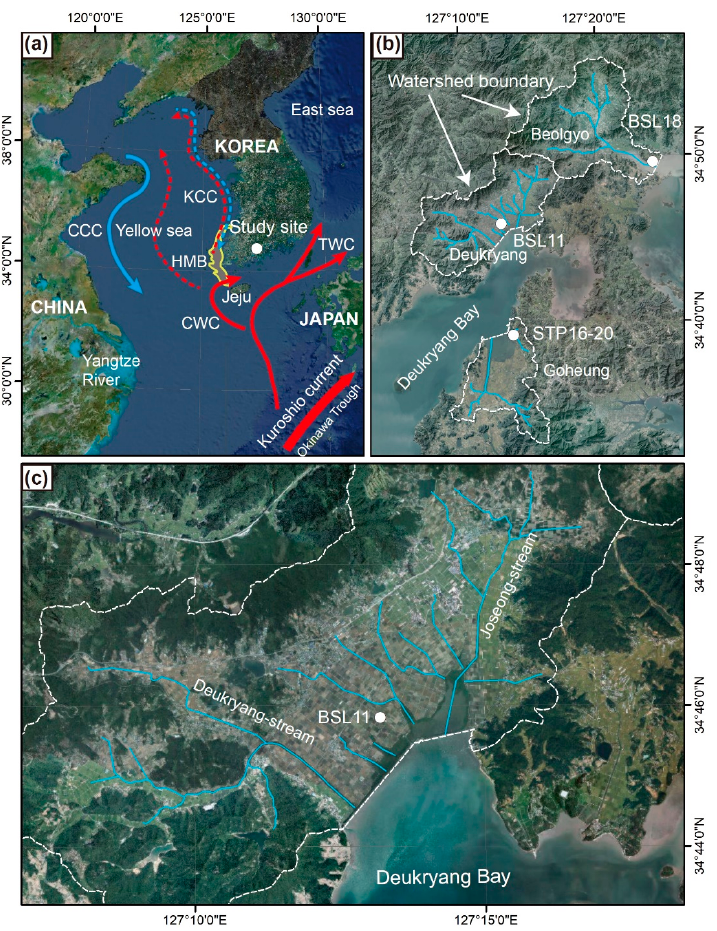
Figure 1. ( a ) Location of the BSL11 core site and surface currents in the Yellow Sea and East China Sea. Blue (red) arrows represent cold (warm) currents. Dashed arrows indicate seasonally varying currents. TWC, Tsushima Warm Current; CWC, Cheju Warm Current; YSWC, Yellow Sea Warm Current; KCC, Korean Coastal Current; CCC, Chinese Coastal Current; CDW, Changjiang Diluted Water. The Heuksan Mud Belt (HMB) is marked by gray shading (modified from Bae et al. [29]). ( b ) Aerial photo around Deukryang, Beolgyo, and Goheung watersheds. ( c ) Aerial photo of Deukryang watershed which has more outlets than Beolgyo, and Goheung watersheds. For interpretation of the references to color in this figure legend, the reader is referred to the Web version of this